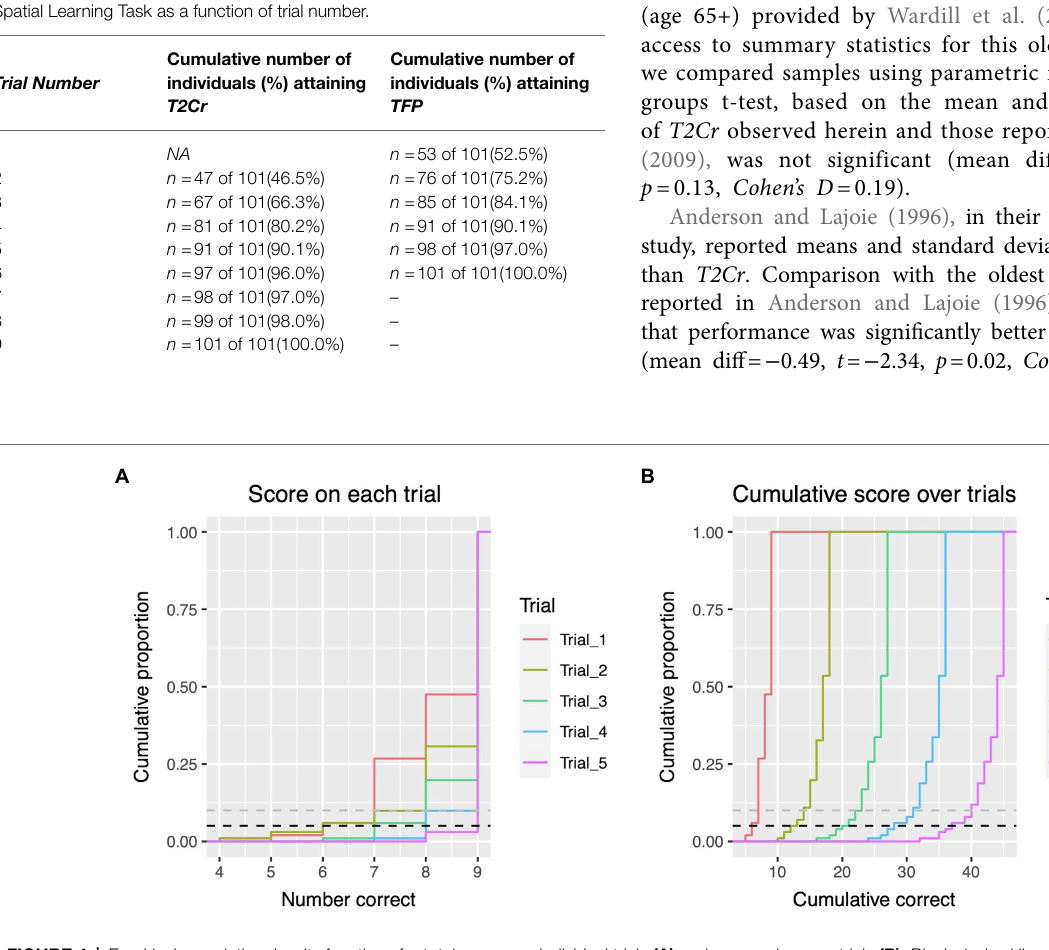
FIGURE 4 | Empirical cumulative density functions for total scores on individual trials (A) and summed across trials (B) . Black dashed line shows 5th percentile; grey dashed line shows 10th